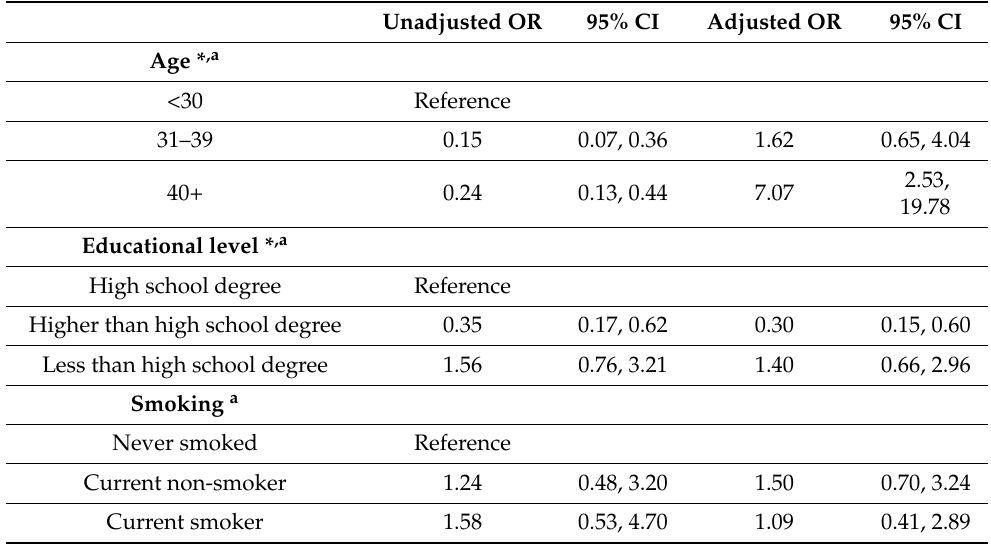
Table 5. Calculated odds ratios that estimate the risk of developing NIHL in relation to several risk